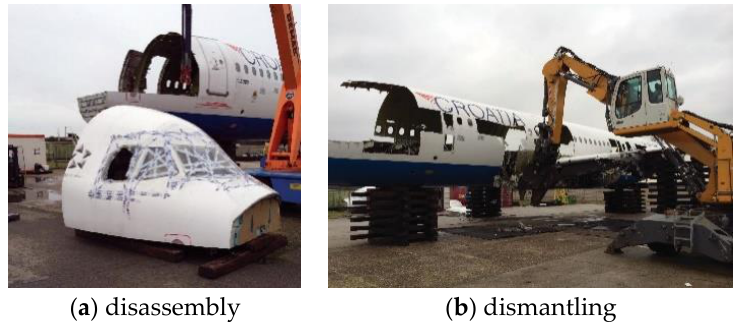
Figure 1. Aircraft disposal and recycle (picture source: courtesy of Aircraft End-of-Life Solutions (AELS) Company).